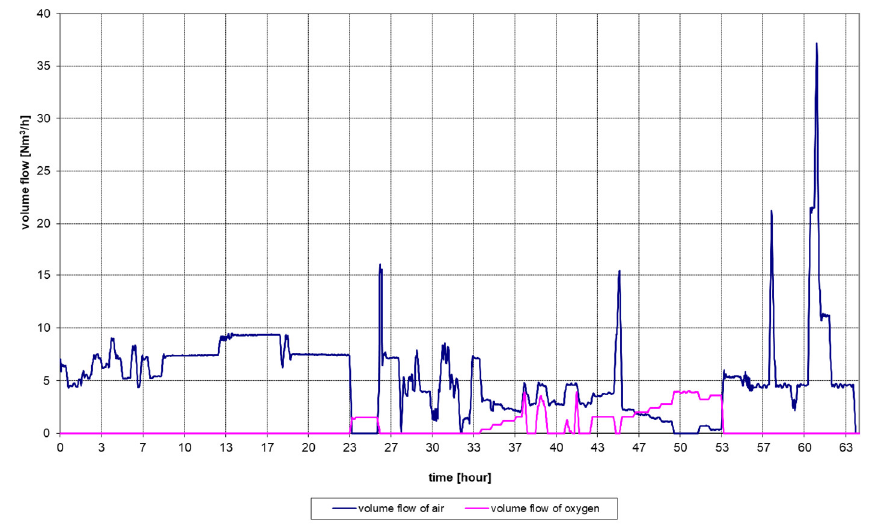
Figure 13. The volume flow of the oxidizers course during the second experiment.